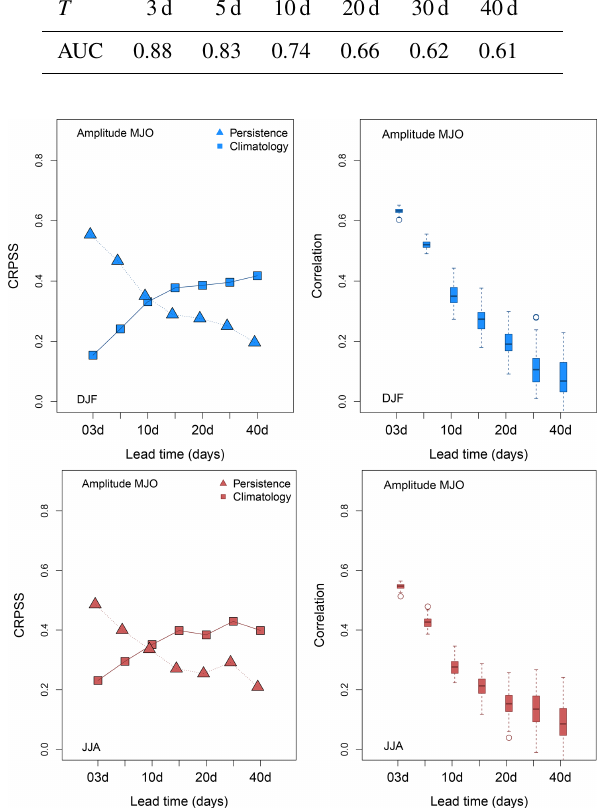
Figure 6. Skill scores for the MJO amplitude for lead times going from 3 to 40d for DJF (blue) and JJA (red) for analogs computed from Z500. Squares indicate CRPSS where the persistence is the reference, triangles indicate CRPSS where the climatology is the reference, and boxplots indicate the probability distribution of cor- relation between observation and the median of 100 simulations for the period from 1979 to